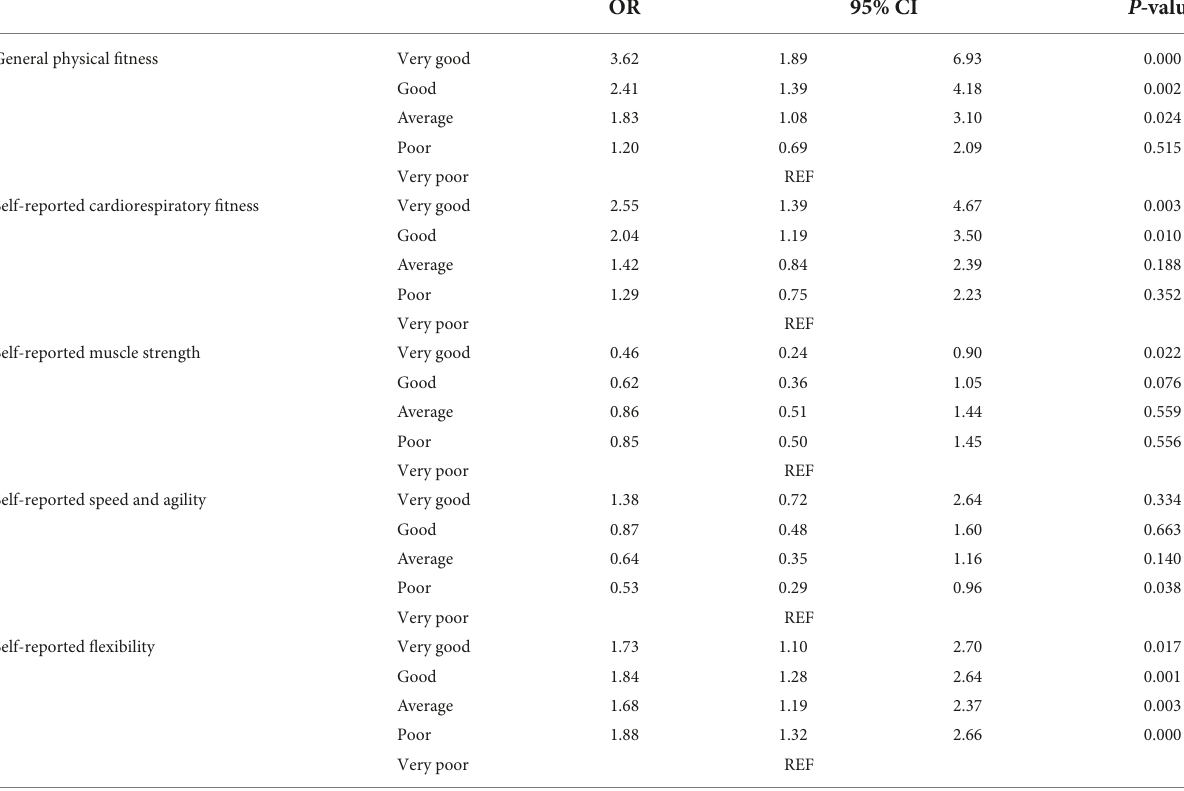
TABLE 5 The association between self-reported physical fitness and body satisfaction.